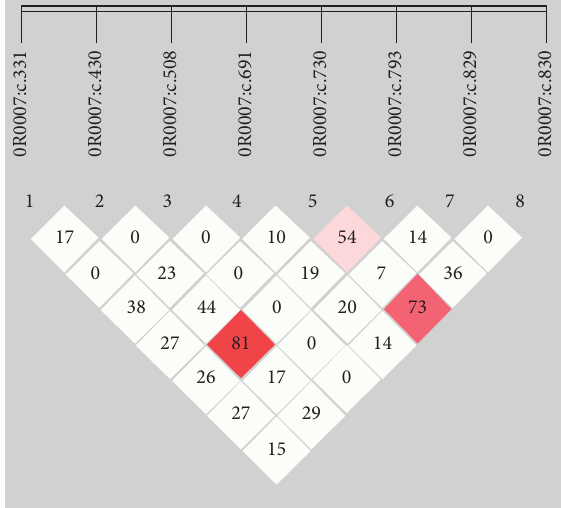
Figure 1: Linkage disequilibrium analyses were performed between pairwise SNP loci in OR0007 gene in the two working populations of Labs. Actual correlation coefficient ( r 2 ) values were magnified 100 times in the small box. Table 7: Prediction of the deleterious effect of the nonsynonymous polymorphism in OR genes by SIFT, PROVEAN, and Align GVGD. SNP Amino acid variant SIFT PROVEAN